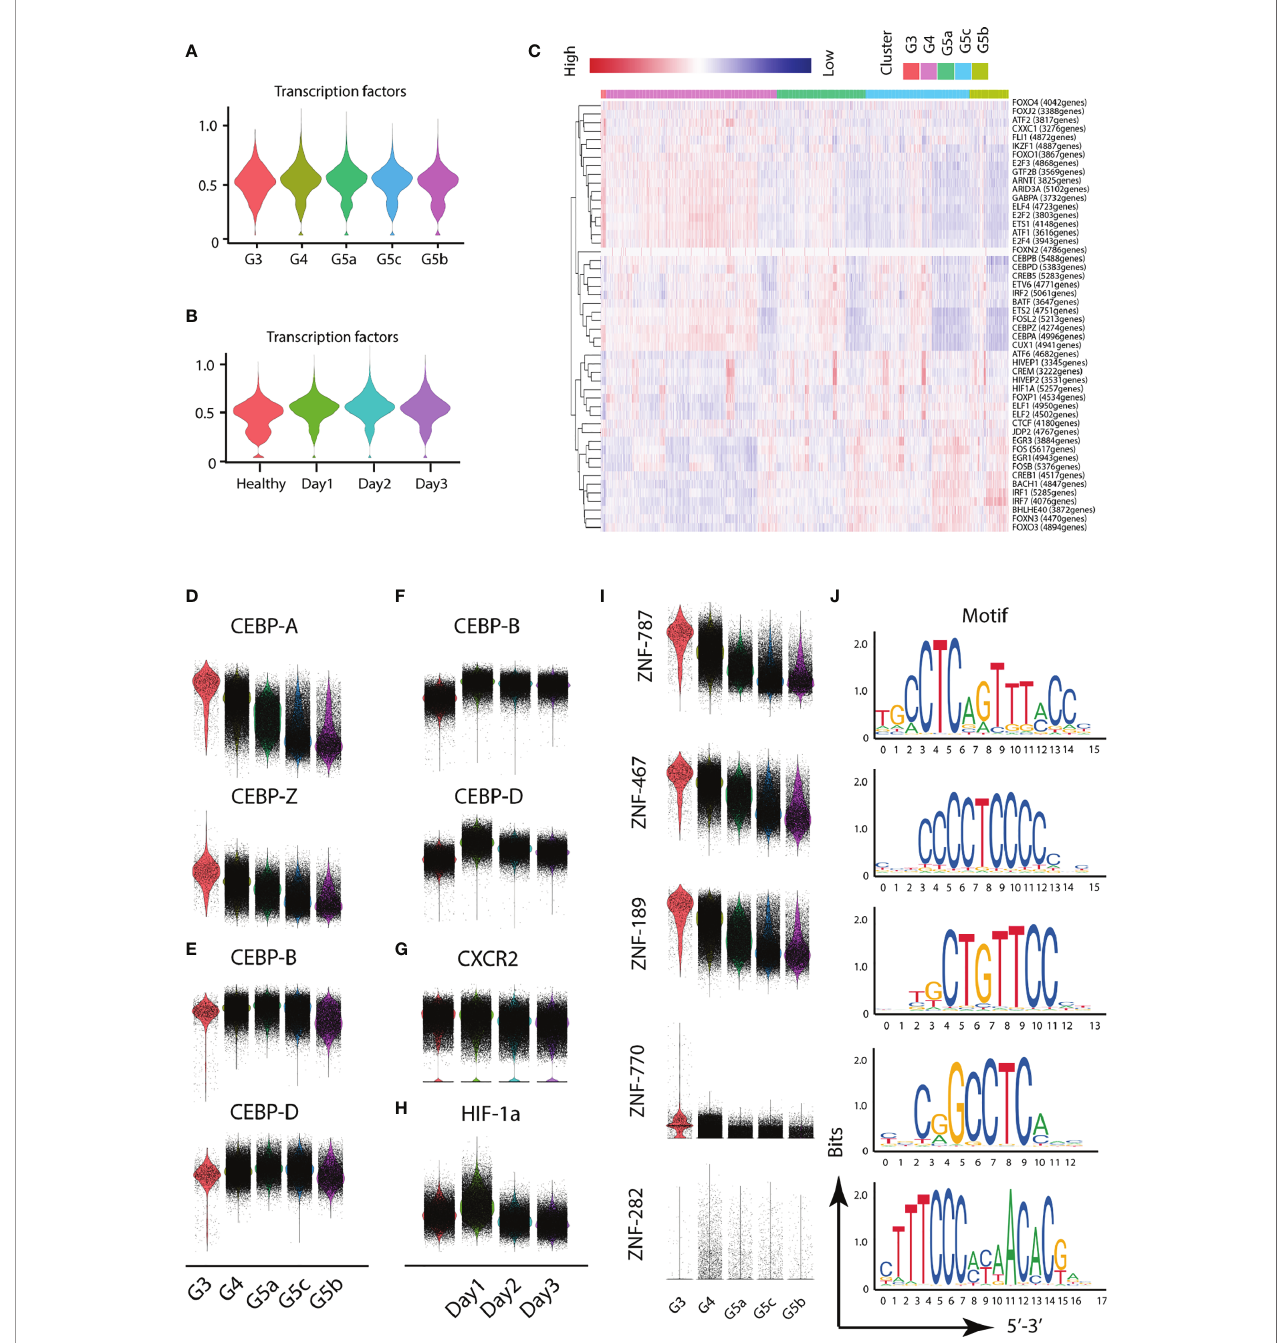
FIGURE 7 | Transcriptional and communication characteristics of neutrophil subsets. (A, B) Violin plot of transcription factors. The transcription characteristics of PMNs in fi ve subgroups (A) , and the transcription characteristics of PMNs in the healthy and burned groups (B) . (C) Heatmap of the difference in expression of transcription factors. (D – H) Differences in expression of related transcription factors under different conditions. (I, J) Expression of fi ve novel transcription factors in each subgroup and prediction of the base